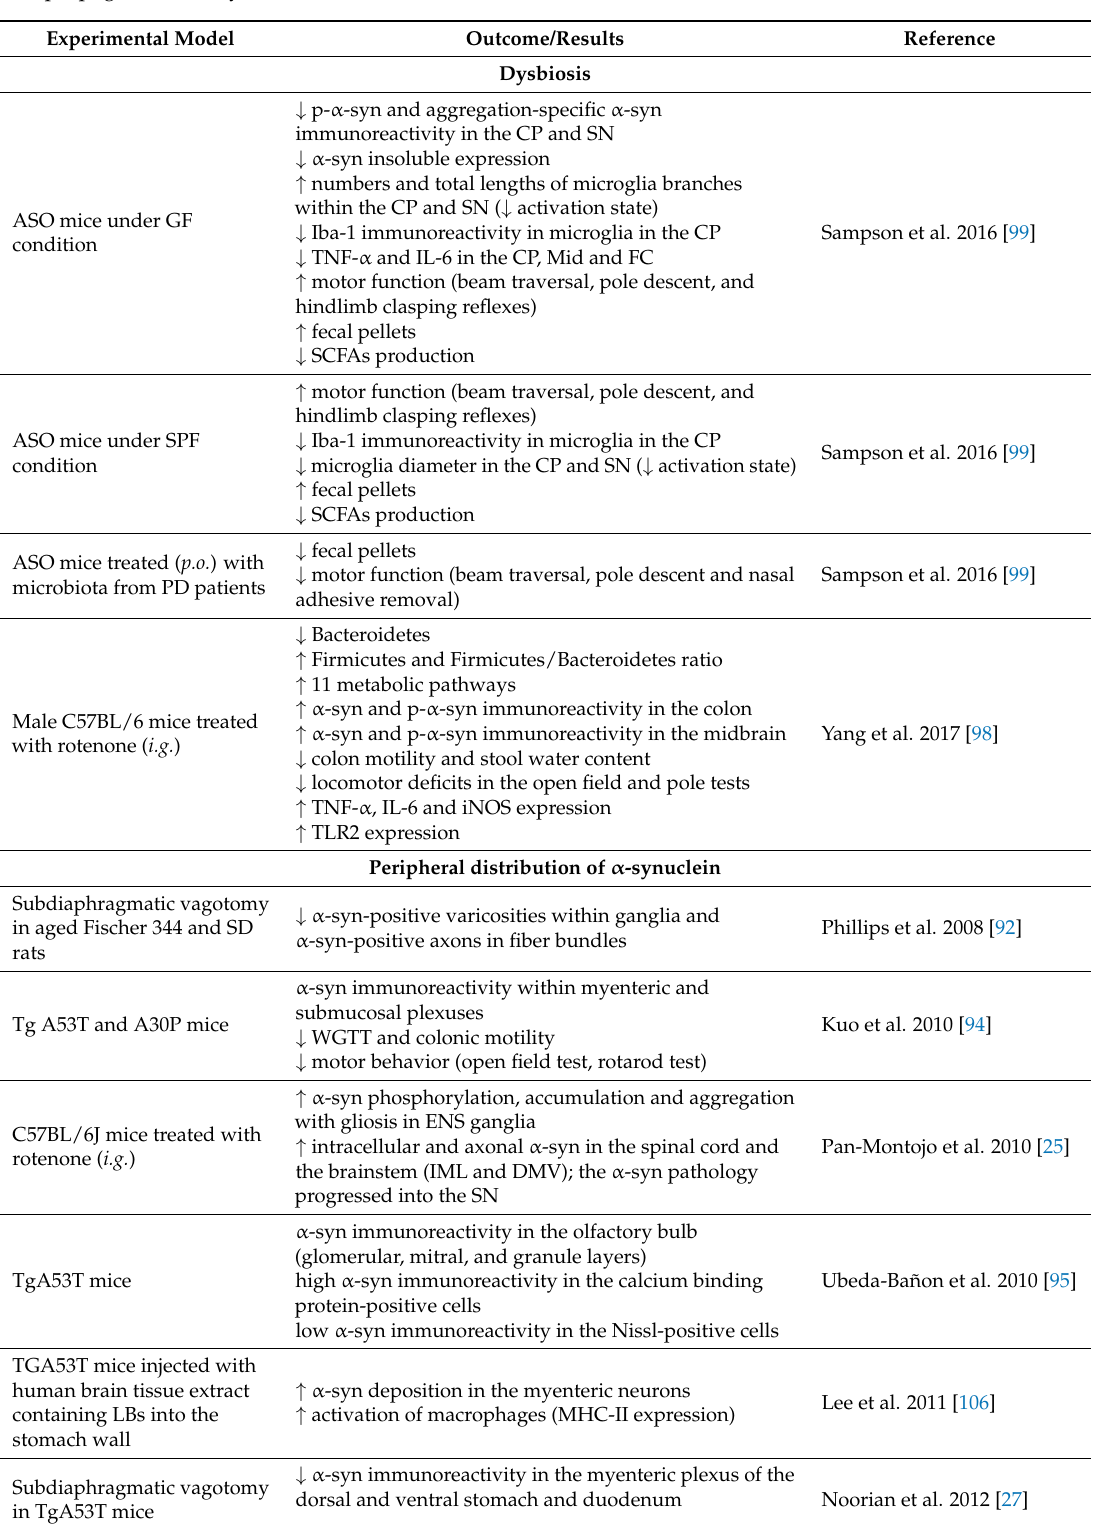
Table 2. Summary of evidence from animal studies for concepts of the gut-brain axis and prion-like propagation of α -synuclein in Parkinson’s